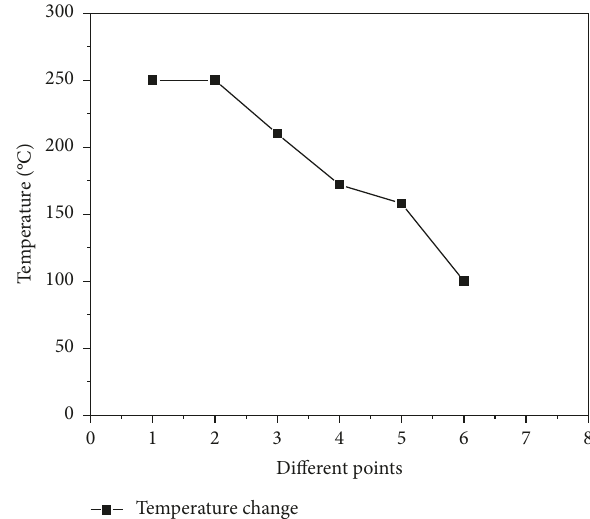
Figure 4: Distribution map of sheet metal temperature at different times of deep drawing.